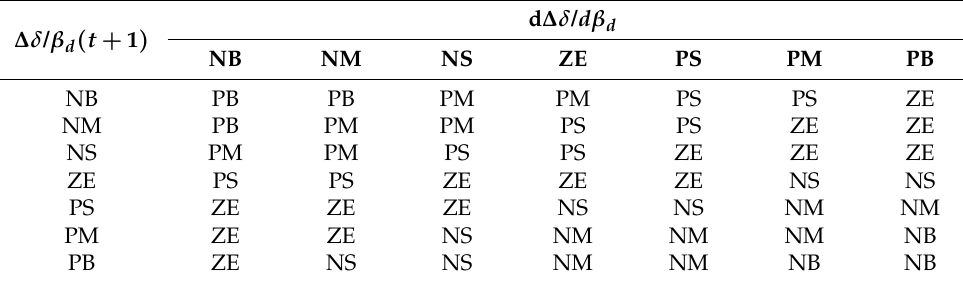
Table 3. Fuzzy rules for ∆ β 1 and ∆ β 2